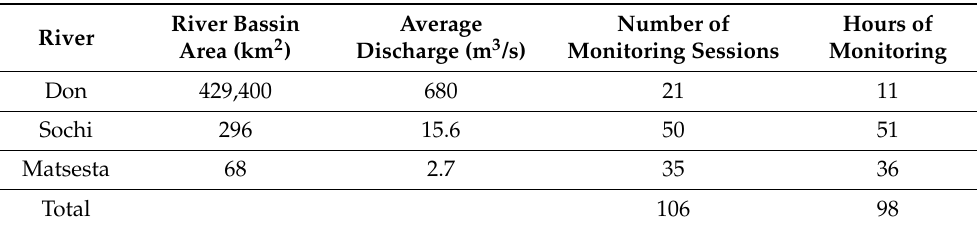
Table 1. The main parameters of the considered rivers and the number of monitoring sessions and